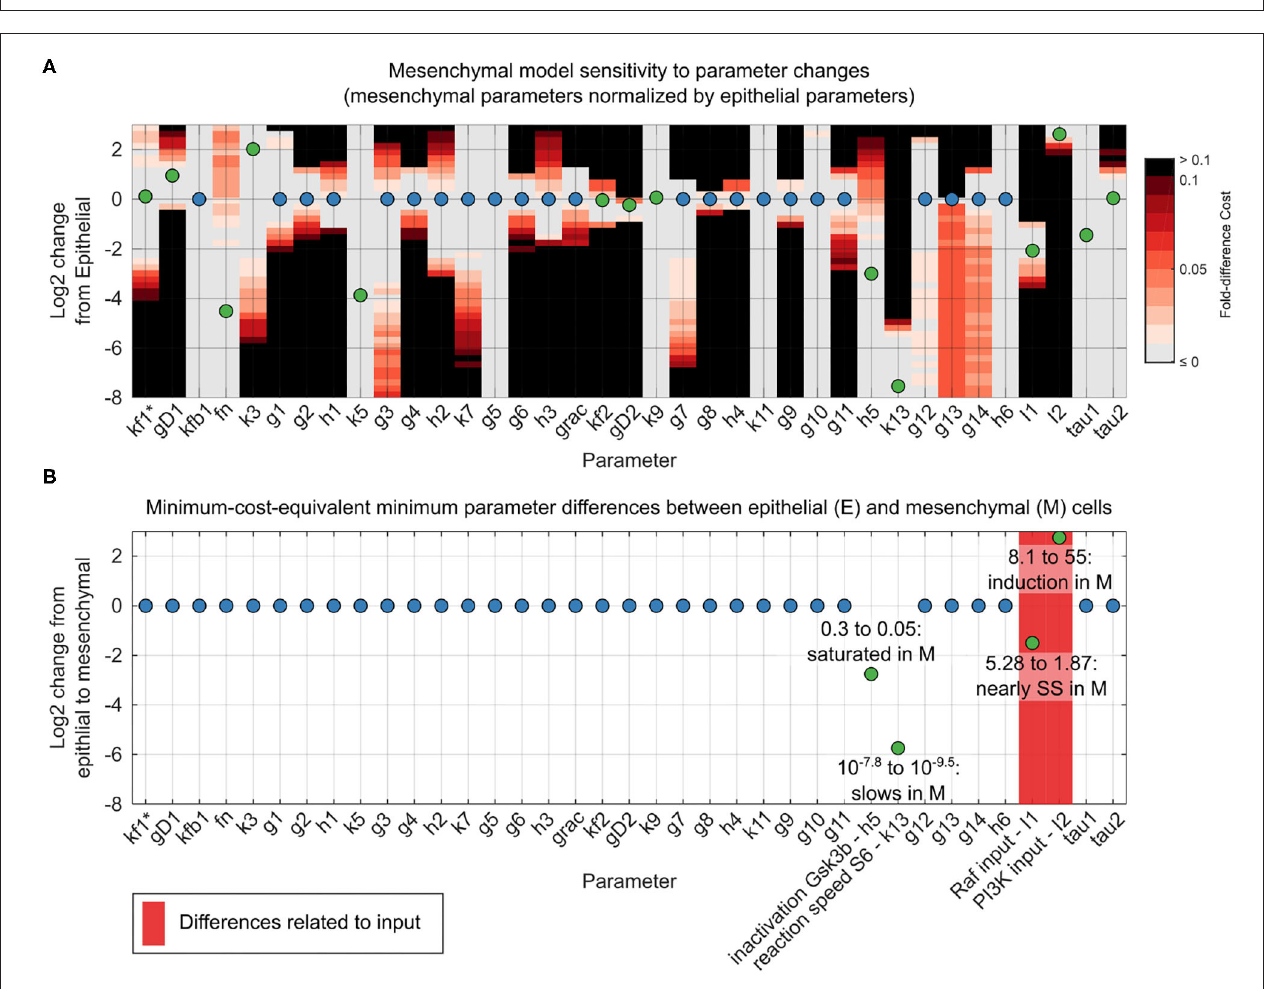
FIGURE 3 | (orange line) for dynamic signaling variables in epithelial (blue solid, left) and mesenchymal (green solid, right) cells. Circles represent means. To enhance visualization, the mean, rather than the marginal distribution, at the 1-min time point is not shown. (C) Data (symbols) and model simulations (line) of covariance between signaling variables over time in cells of both phenotypes. Black bars represent the range of covariances across replicates. All values in (B,C) were calculated by random subsampling of cells across experimental replicates.